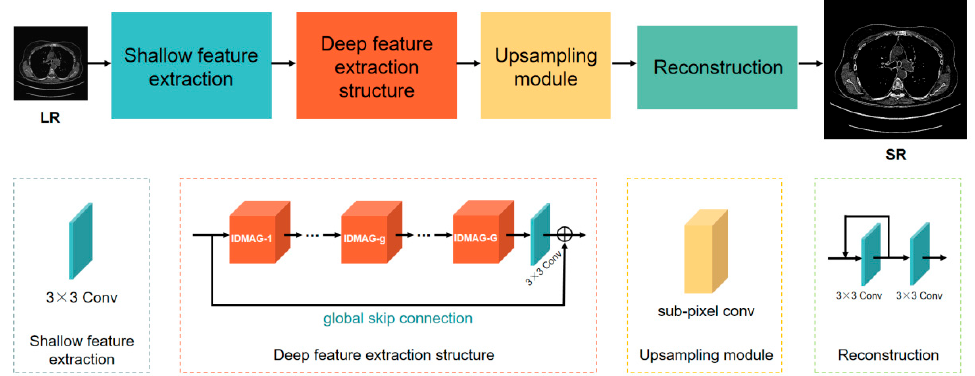
Figure 1. The architecture of information distillation and multi-scale attention network (IDMAN) comprises four parts: shallow feature extraction, deep feature extraction structure (DFES), upsampling module and reconstruction.